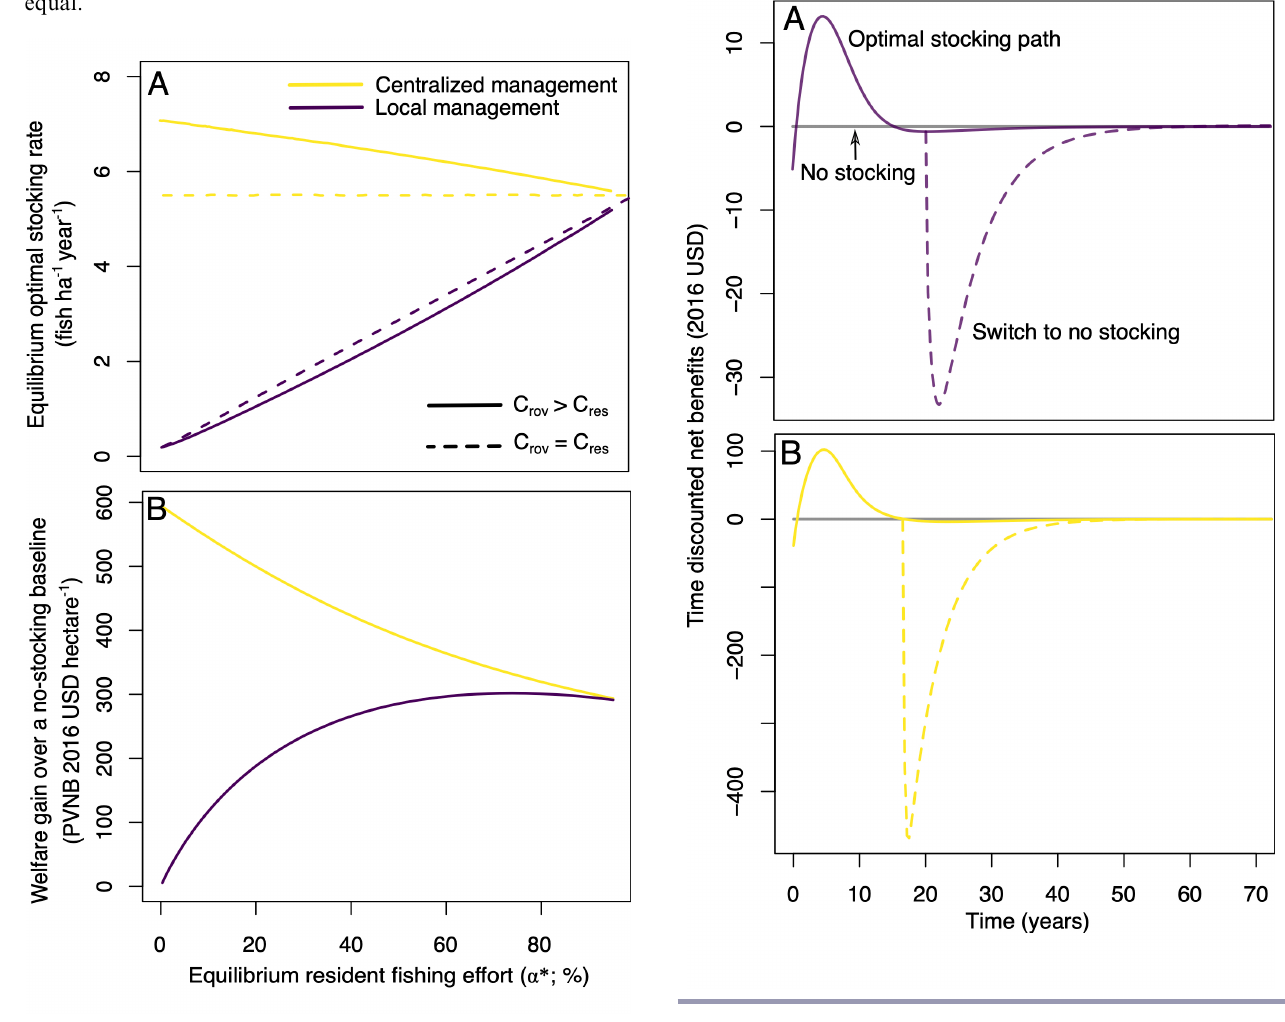
relative to residents (Appendix 3), but were present even when we set the value of harvest equal for rovers and residents (dashed yellow line in Fig. 1A). The centralized manager’s more inclusive definition of welfare also meant that, unlike under local management, the optimal stocking rate and the welfare gains from stocking were negatively related to the contribution of resident anglers to total equilibrium effort (Fig. 1A, 1B). When residents comprised most of the angling effort, centralized and local management led to similar stocking rates and welfare gains. Fig. 1 . (A) Optimal stocking rate and (B) welfare gain (present value of net benefits [PVNB]) from stocking relative to a no- stocking baseline, under local management by a collective action organization of lakeshore residents or centralized management by a government agency. The optimal investment and the resulting welfare gain depend on the proportion of total equilibrium angling effort that is comprised of resident anglers (x-axis). The solid line shows the default condition when access costs are higher for roving anglers than for resident anglers; the dashed line shows the case when access costs are equal.